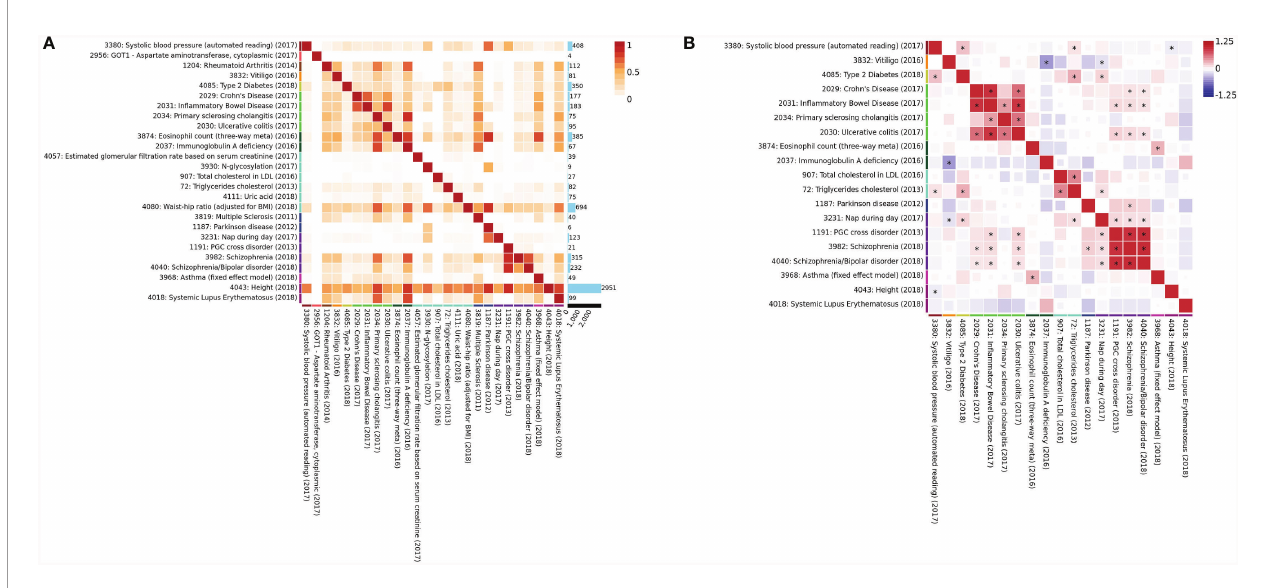
FIGURE 6 | Multimarker analysis and genetic correlation. (A) Multi-marker Analysis of GenoMic Annotation (MAGMA) genes overlap. Each cell represents the proportion of overlapped signi fi cant genes ( p -value <2.5E − 06) between the two GWAS on the number of signi fi cant genes in both GWAS on the rows and columns and divided by the number of signi fi cant genes in each GWAS. Rectangles next to the trait labels are colored based on the domain of the trait. (B) Genetic correlation. An asterisk in the box indicates the correlation passes the Bonferroni signi fi cance threshold ( p < 0.05). Rectangles next to the trait labels are colored based on the domain of the trait. Phenotypes are clustered into 24 domains and derived from public genome-wide association study summary